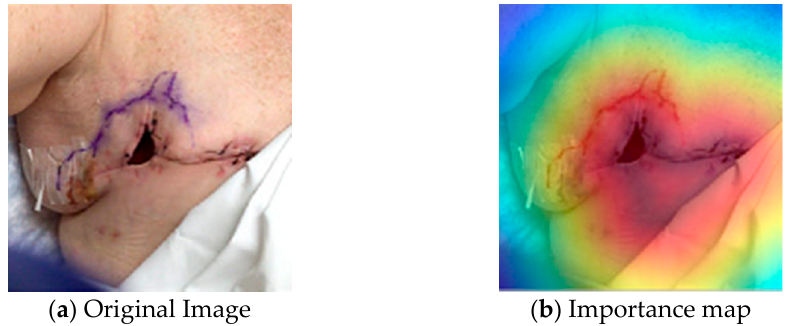
Figure 12. The probabilities of wound types: Surgical: 63.4%, diabetic: 19.4%, pressure injury: 15%,